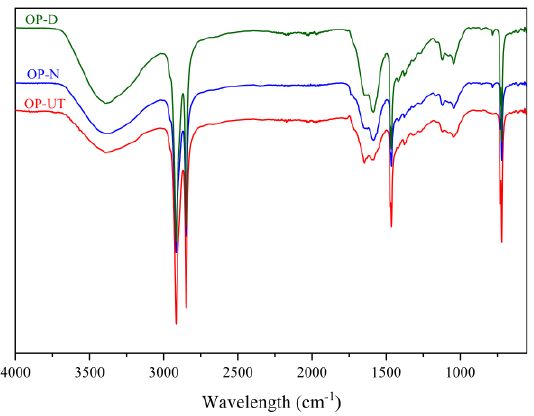
Figure 3. FTIR spectra of the developed biocomposites.